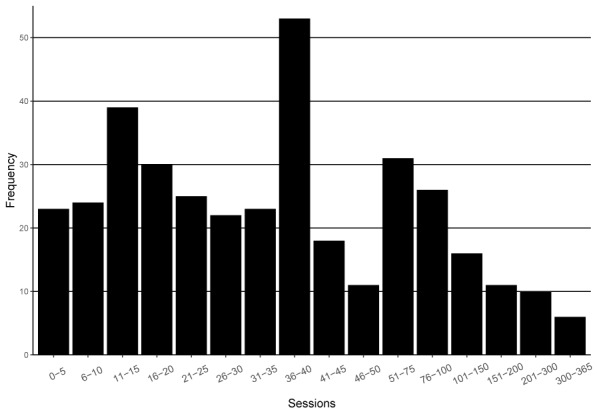
Treatment length.